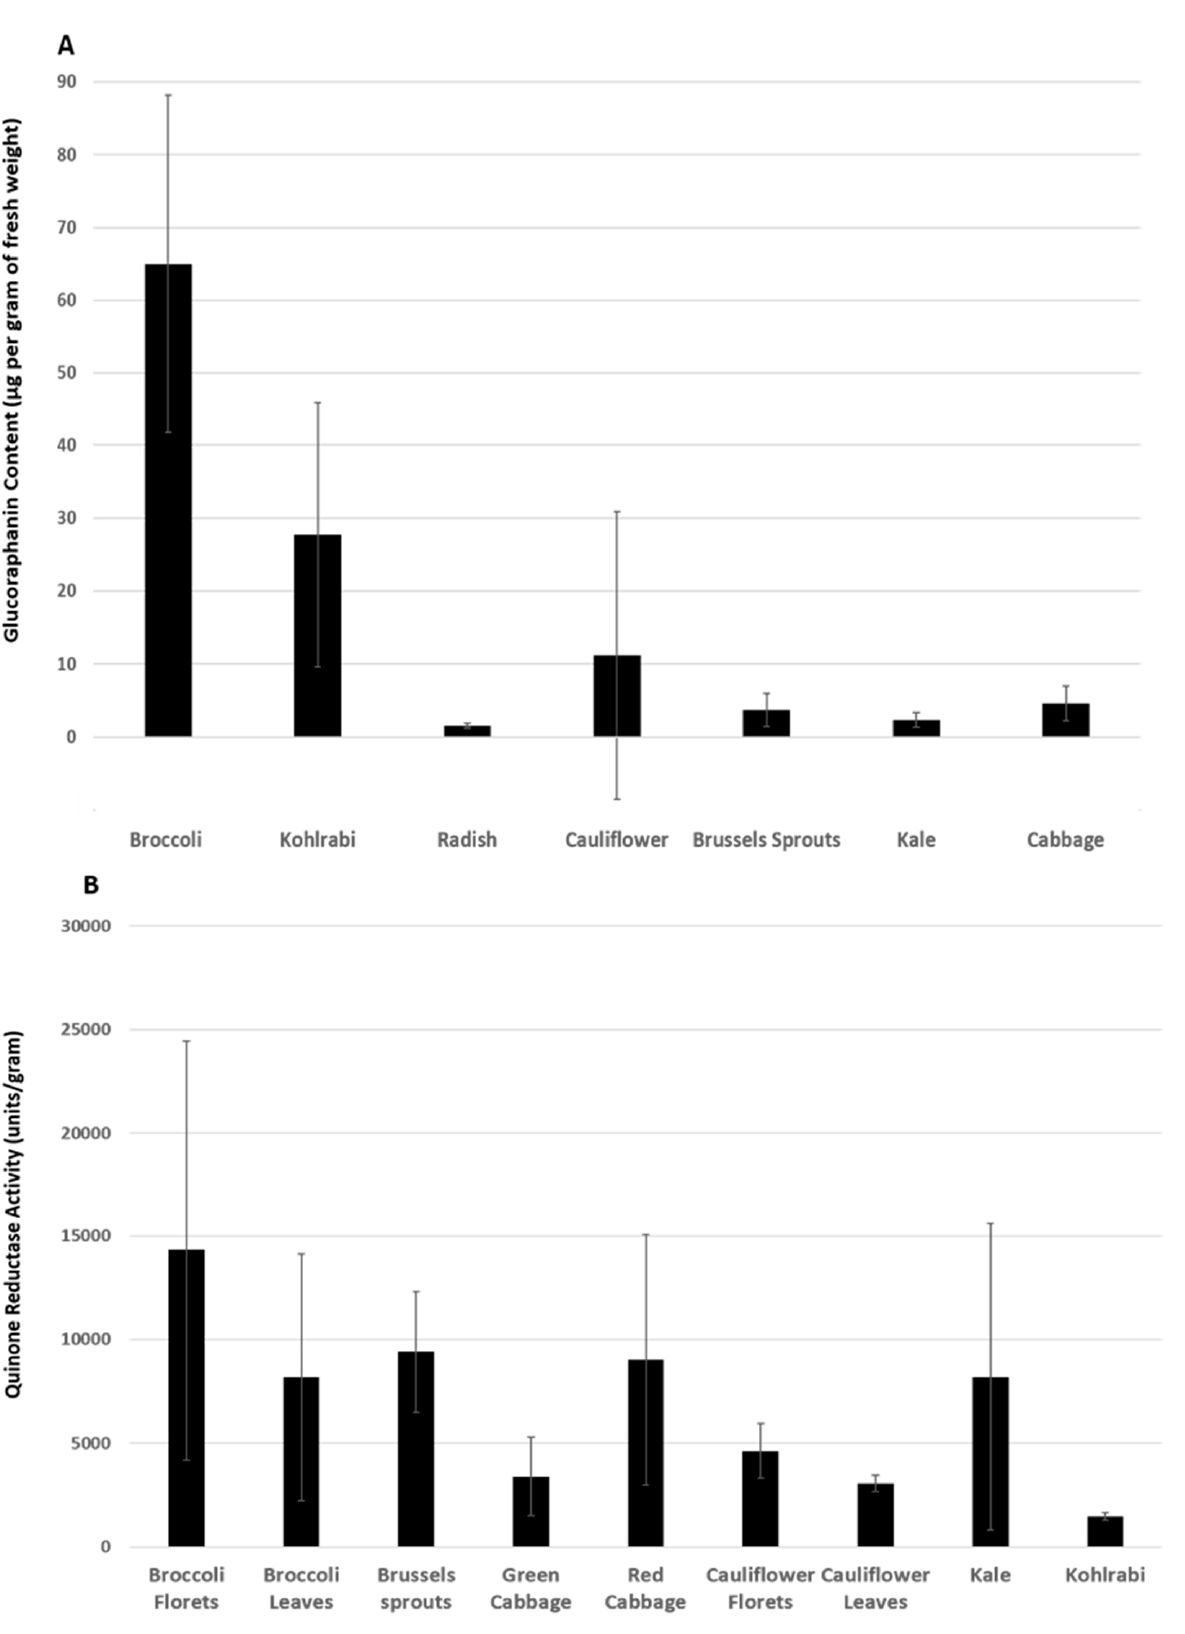
Figure 1. ( A ) Glucoraphanin content in the seeds of various Brassica vegetables. Data summarized from West et al. [88]. ( B ) Antioxidant ability of extracts of various Brassica vegetables, measured as quinone reductase activity induced in Hepa 1c1c7 murine hepatoma cells. Data summarized from Prochaska et al. [89].